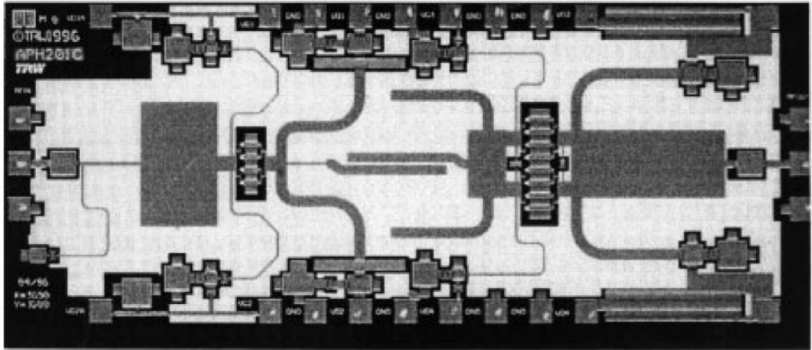
Figure 18. The 2-stage balanced PA in 150 nm GaAs HEMT